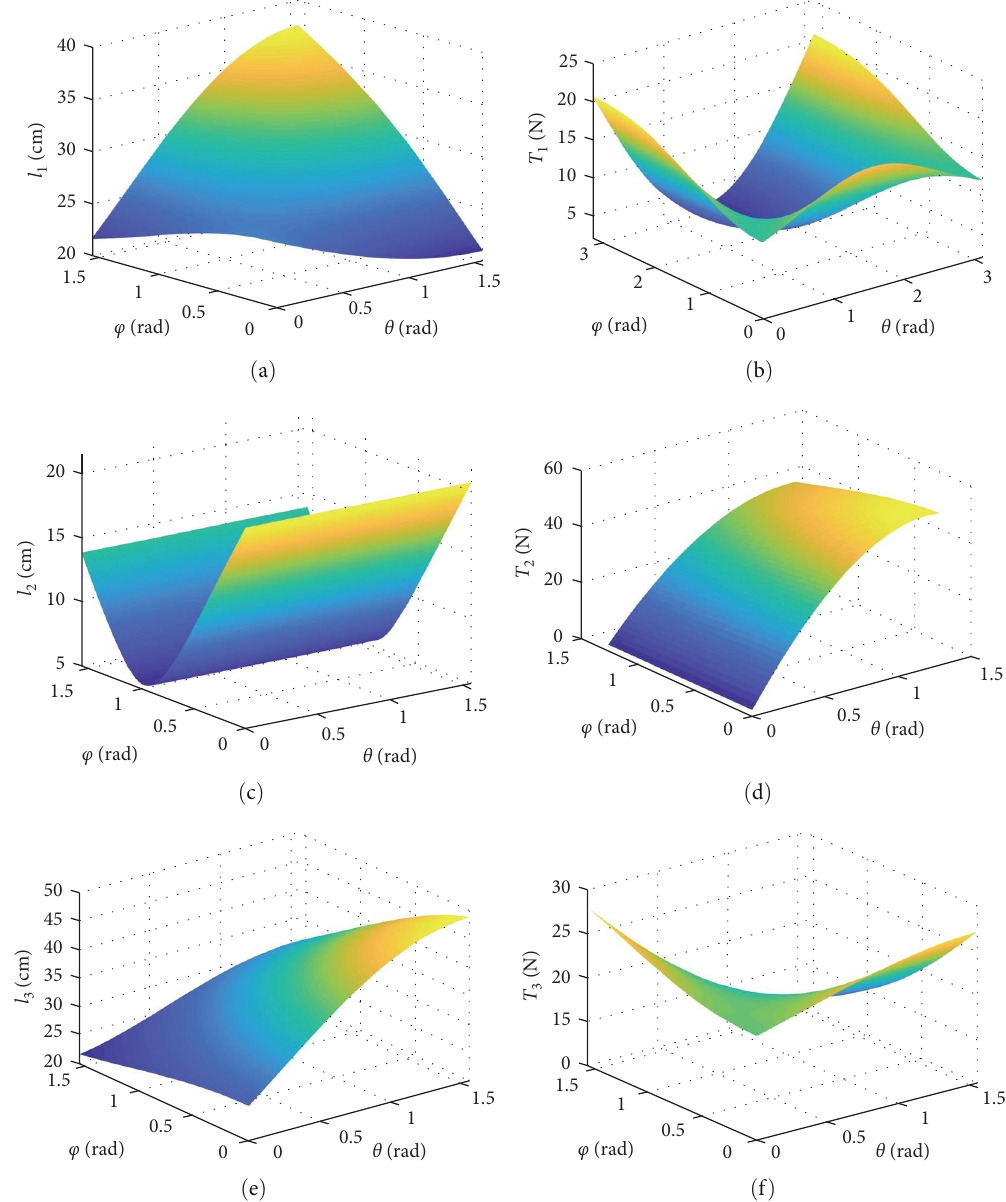
F IGURE 8: Inverse position and statics illustration. (a) The length changes of cable 1. (b) The length changes of spring. (c) The length changes of cable 3. (d) The tension changes of cable 1. (e) The tension changes of spring. (f) The tension changes of cable